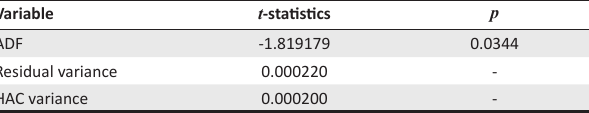
TABLE 2-A1: Kao panel cointegration test results.